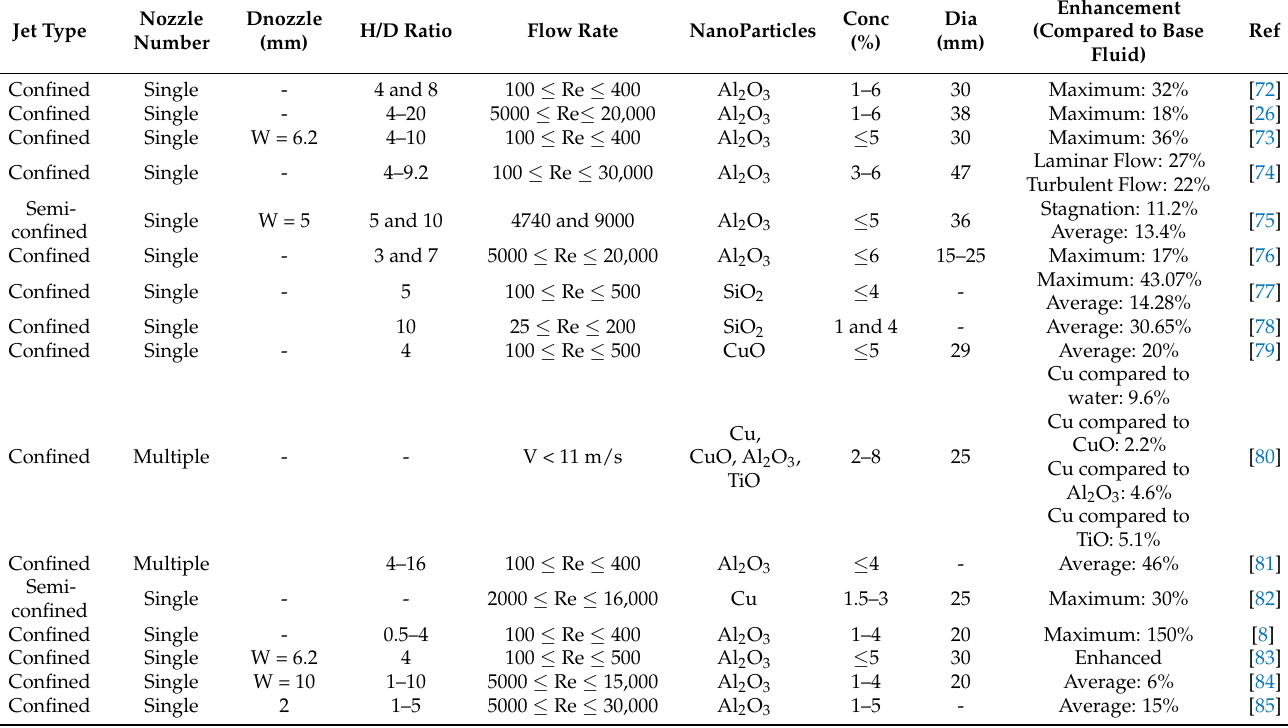
Table 7. Summary of past numerical studies with single-phase and two-phase